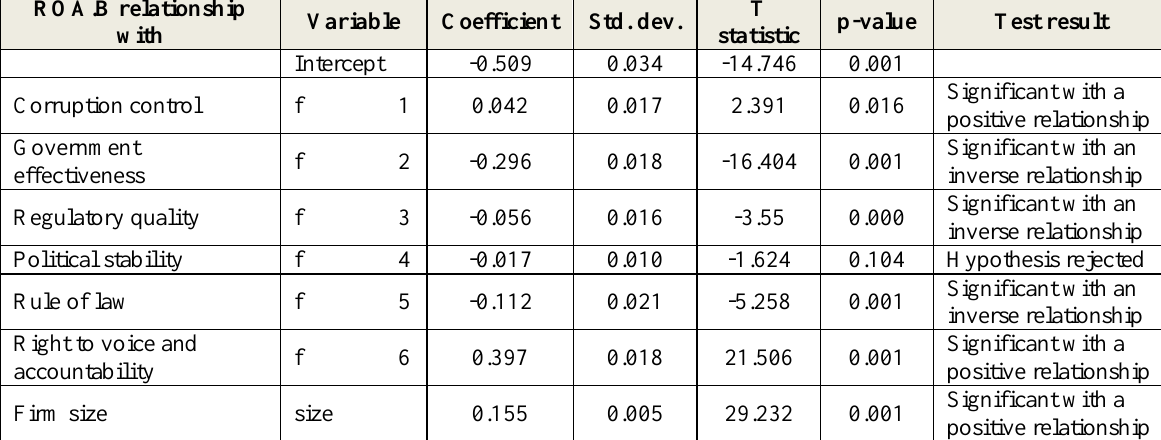
Table 6. ROA.B relationship with governance